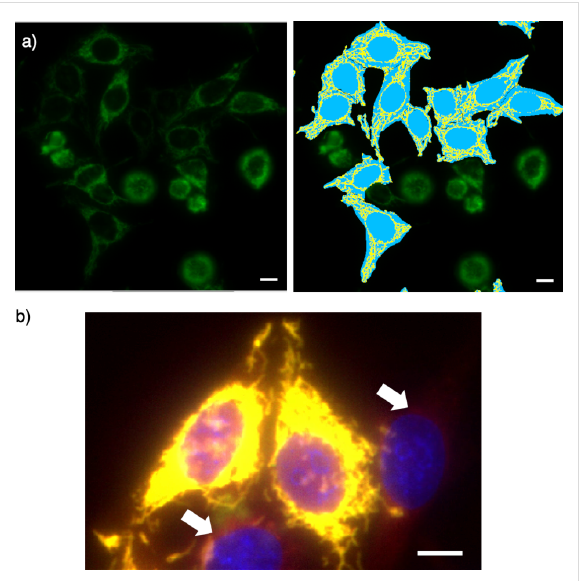
Figure 7: Examples from the automated HC imaging of stable HGM cells with HaloTag–GFP on mitochondria, labeled with 26 and Hoechst dye. a) GFP channel (left) and cell selection (right), showing the cell body mask (light blue areas) and the mitochondrial mask (yellow areas). b) Overlay image of the GFP (green), 26 (red), and the Hoechst dye (blue) channels, showing off-target fluorescence from 26 (white arrows). Scale bar: 10